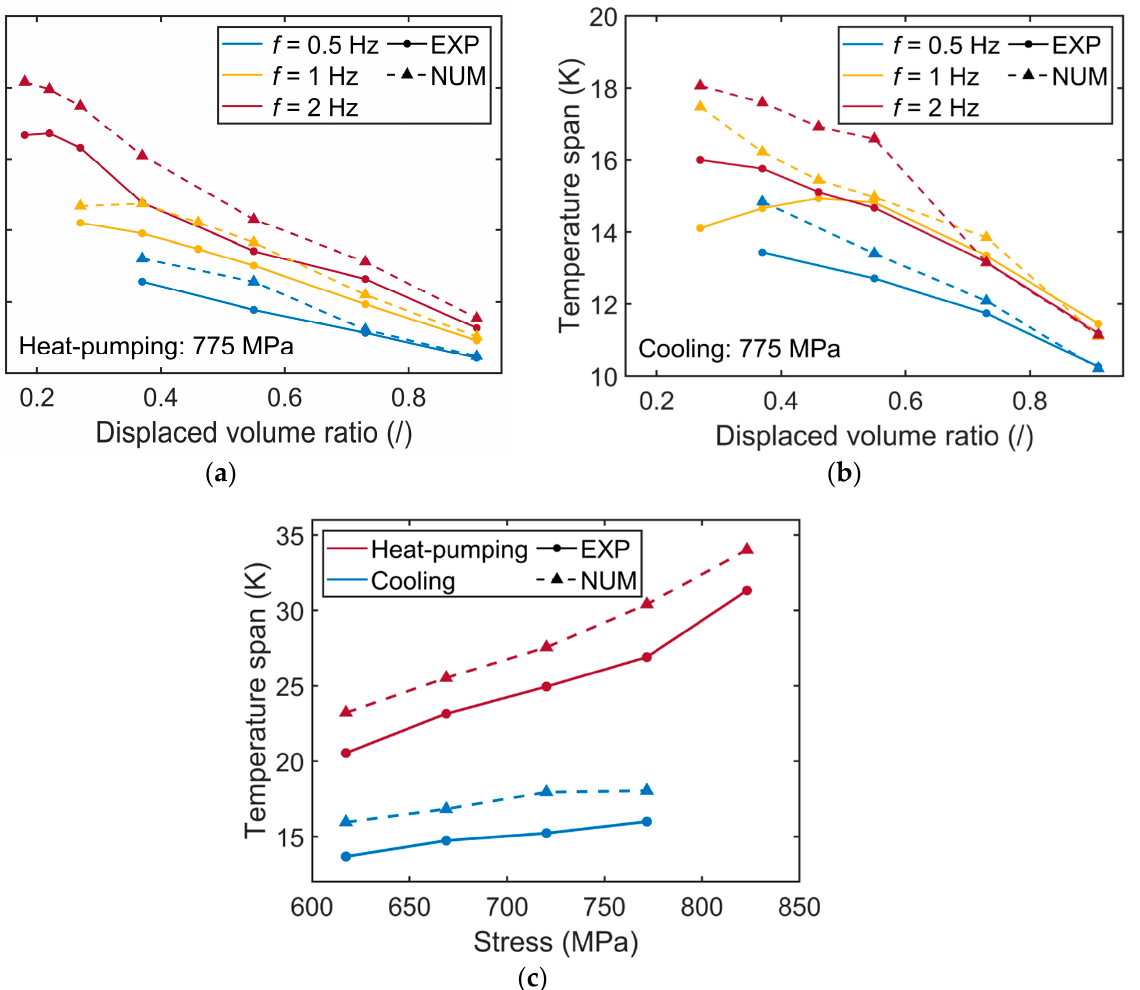
Figure 7. Comparison between experimentally determined and numerically calculated maximum temperature spans established along the AeCR under different operating conditions for heat-pumping ( a ) at a stress level of 775 MPa and cooling ( b ) and under different mechanical loads ( c ).